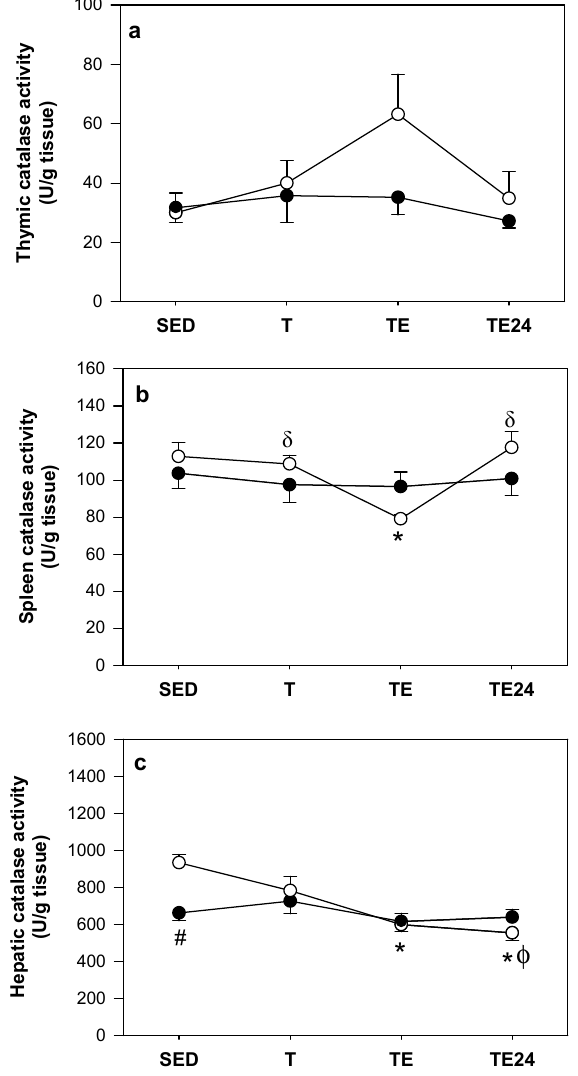
Figure 6. Catalase activity in the thymus ( a ), spleen ( b ) and liver ( c ) at the end of the study. The non-supplemented groups are represented by white symbols ( ⚪ ) and the hesperidin groups by black symbols ( ⚫ ). SED = sedentary group, T = trained group, TE = T group with an additional exhaustion test, TE24 = TE group 24 h after the exhaustion test. Data are expressed as mean ± SEM ( n = 7–8). Statistical differences (Mann–Whitney U test): # p < 0.05 between non-supplemented and the hesperidin-supplemented groups; * p < 0.05 vs. SED group just in the non-supplemented animals; δ p < 0.05 vs. TE group just in the non-supplemented animals; φ p < 0.05 vs. T group just in the non-supplemented animals.